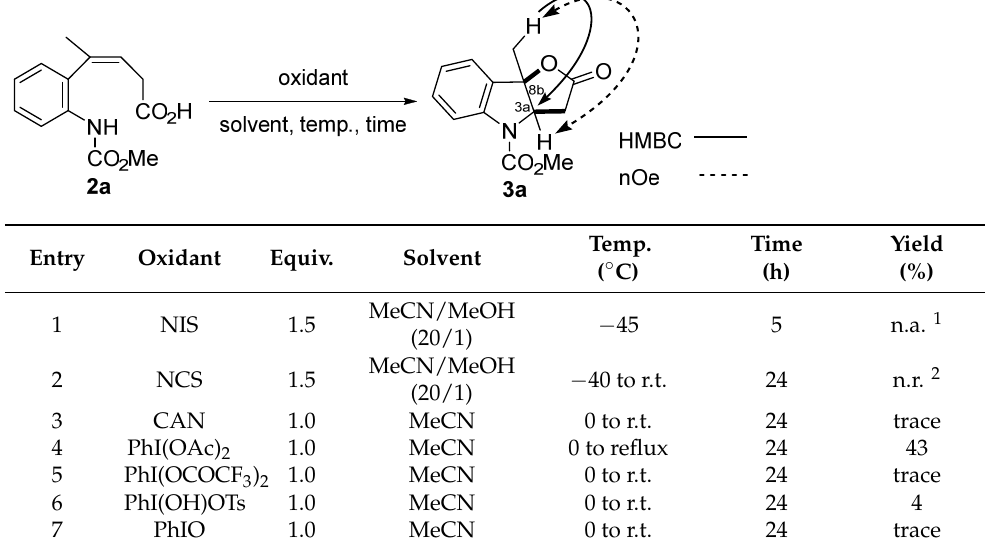
Table 1. Oxidative cyclization of alkene 2a .